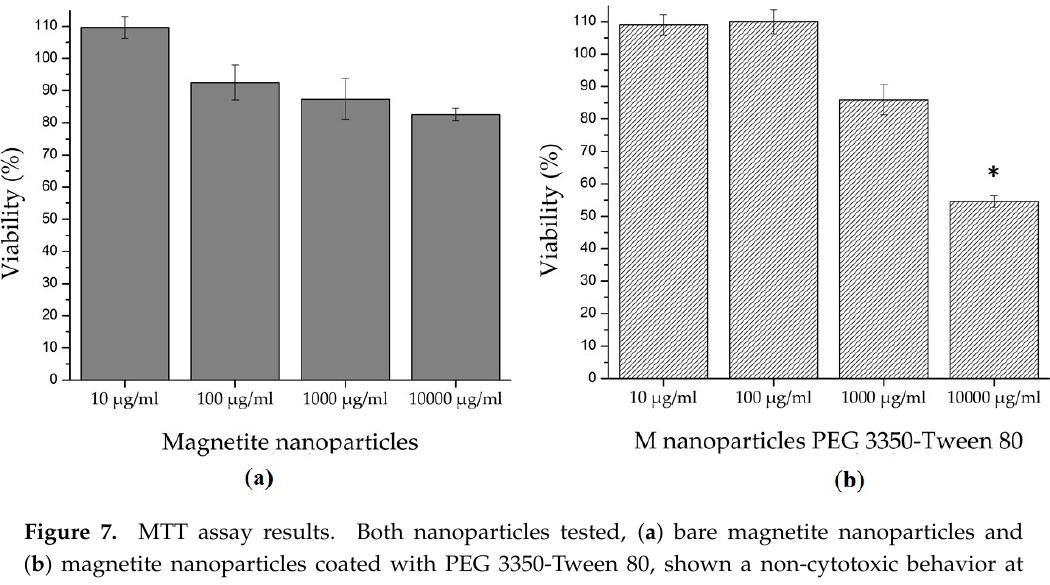
Figure 7. MTT assay results. Both nanoparticles tested, ( a ) bare magnetite nanoparticles and ( b ) magnetite nanoparticles coated with PEG 3350-Tween 80, shown a non-cytotoxic behavior at concentrations from 10 to 1000 µg/mL. At concentrations of 10,000 µg/mL, only magnetite nanoparticles coated with PEG 3350-Tween 80 show a cytotoxic effect with a significant difference* in comparison to the negative control.